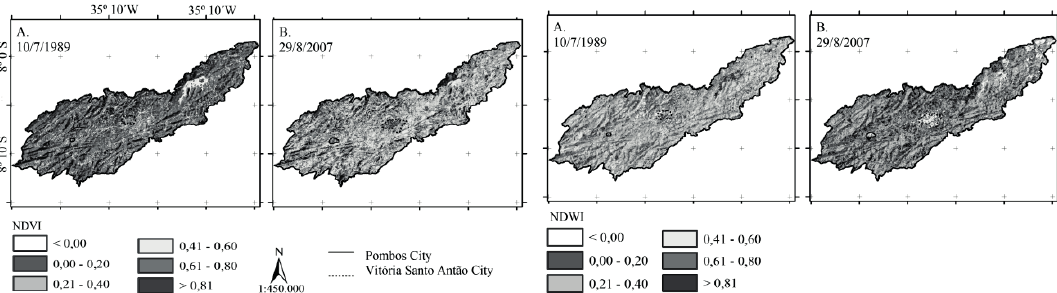
Fig. 3 Vegetation Index (NDVI) and Water Index Normalized Difference (NDWI) in Tapacurá basin–